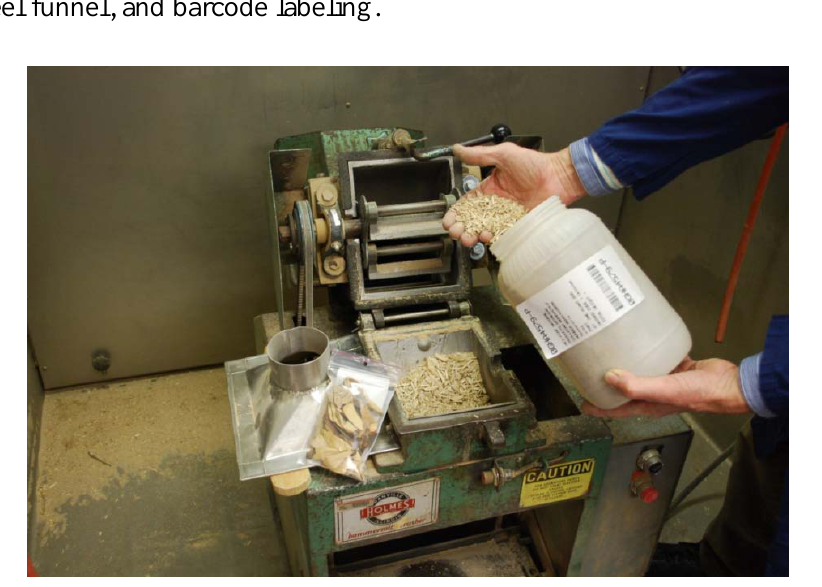
Figure 3. Dry Plant Grinding with a Holmes Hammermill. Note voucher, purpose-built stainless steel funnel, and barcode